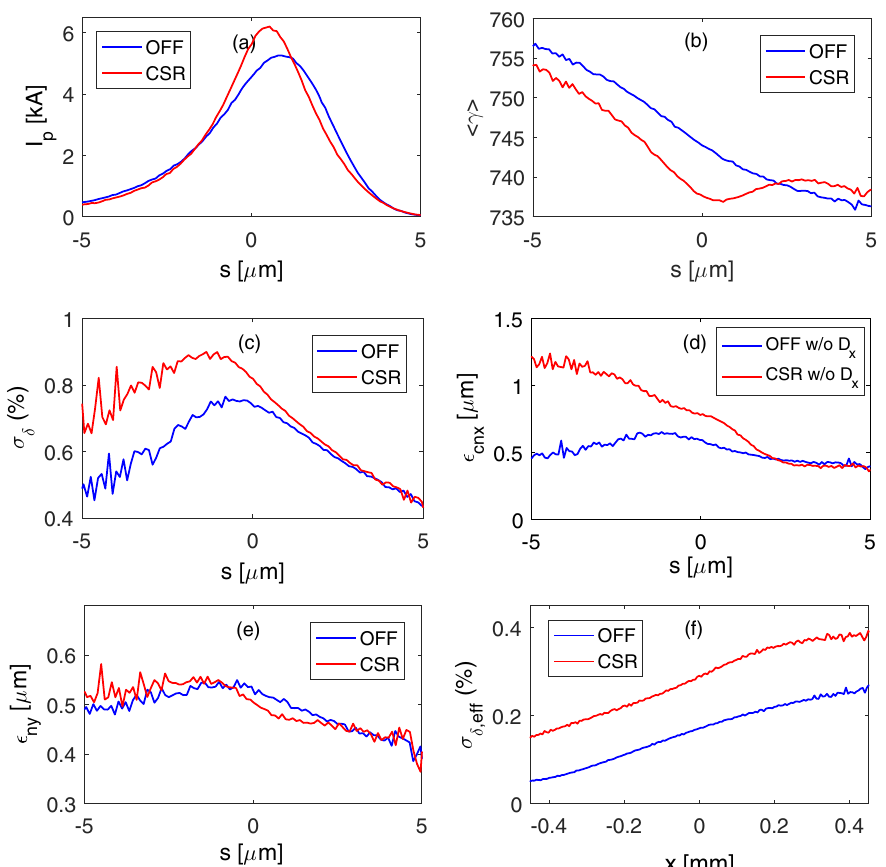
FIG. 6. LPA beam properties at the entrance of the TGU with (red) and without (blue) CSR effects, including the current distribution (a), the slice average energy (b), the slice energy spread (c), the slice transverse emittances (d) and (e), and the x-slice effective energy spread (f). Part (d) excludes dispersion